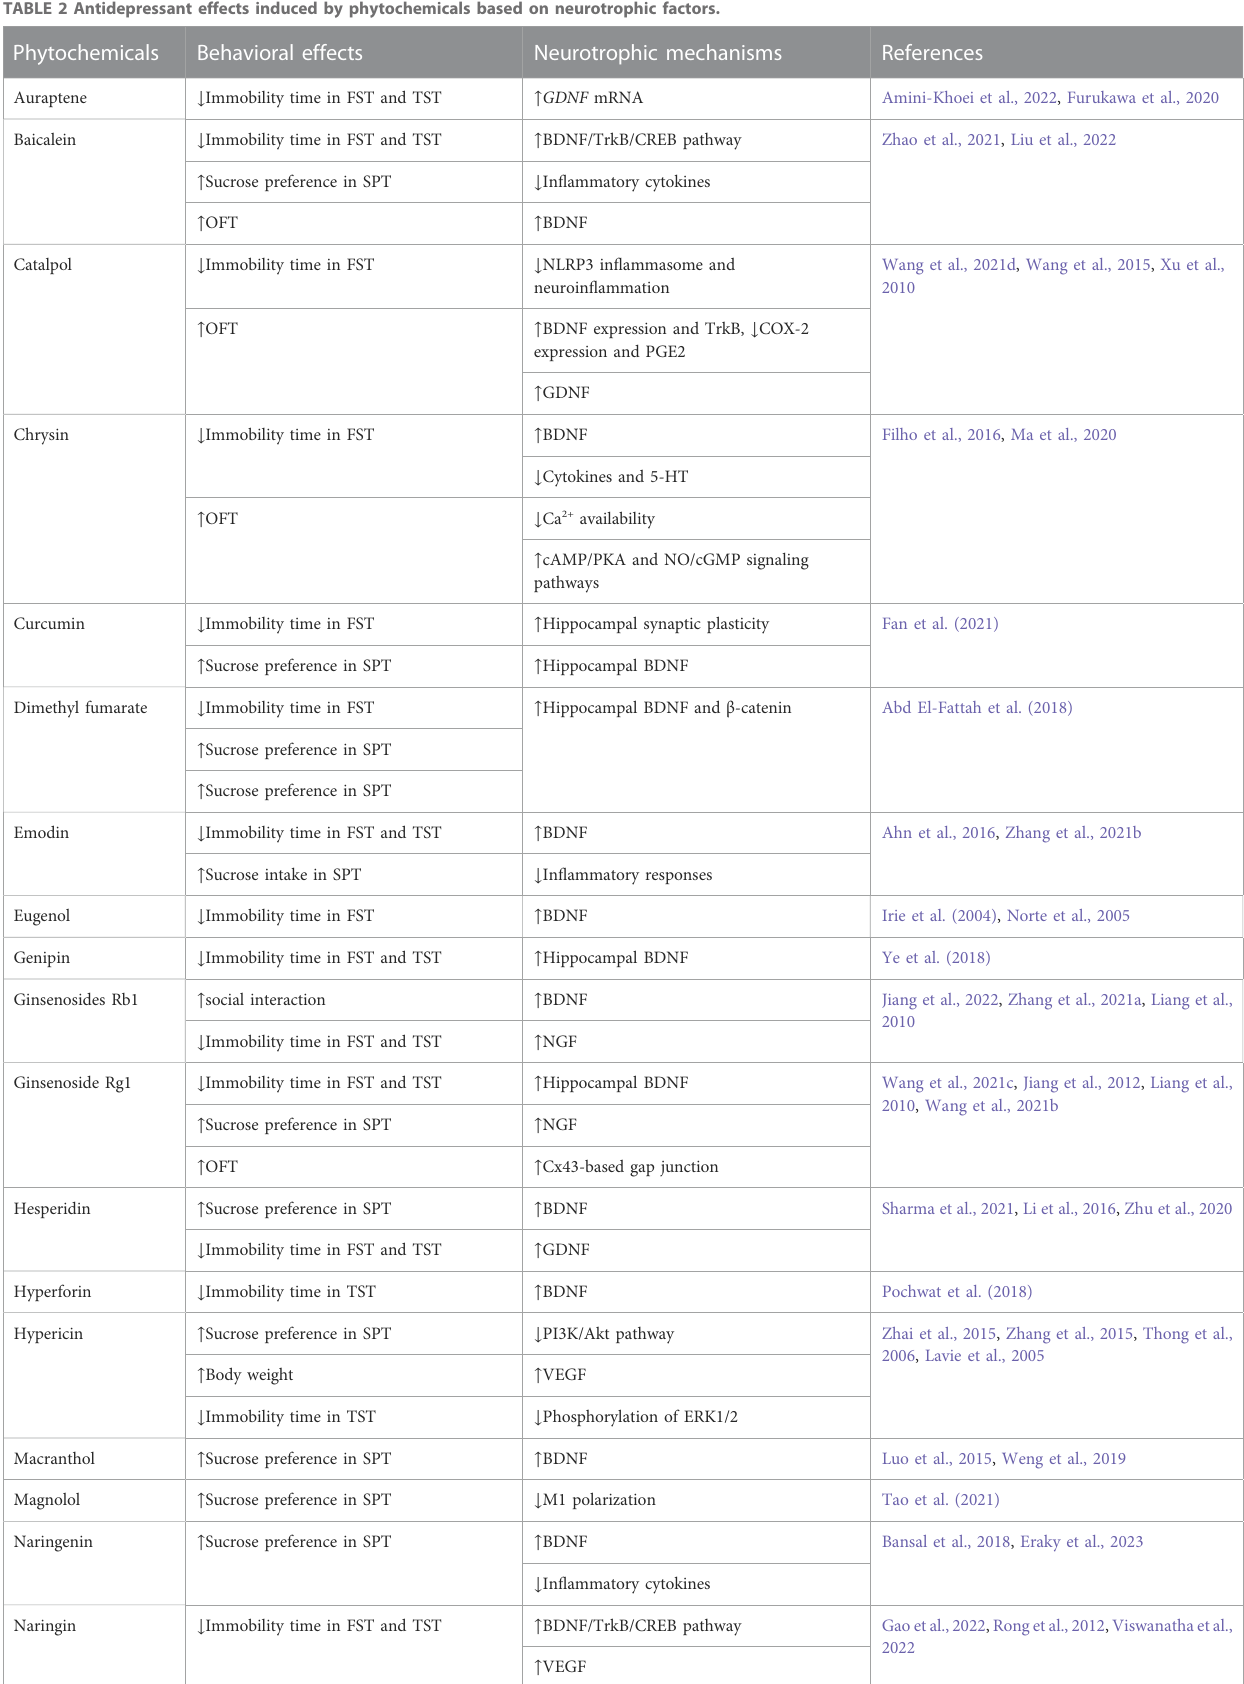
TABLE 2 Antidepressant effects induced by phytochemicals based on neurotrophic